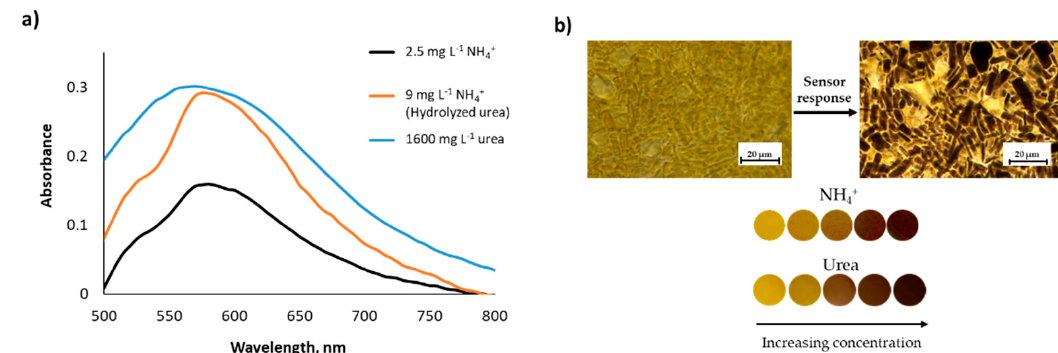
Figure 3. ( a ) Difference in UV-Vis spectra between standards of 2.5 mg L − 1 NH 4+ (black line), 9 mg L − 1 NH 4+ coming from hydrolyzed urea (orange line), and 1600 mg L − 1 urea (blue line) and the blank standard. ( b ) Top: Optical microscopy images of the PDMS membrane before (left) and after (right) being exposed to ammonium/urea in solution, scale bar: 20 µ m. Bottom: Sensor photos referring to the evolution of the sensor color as a function of ammonium or urea concentration in solution. Table 1. Calibration curves obtained for ammonia, urea, and hydrolyzed urea determination. Analyte